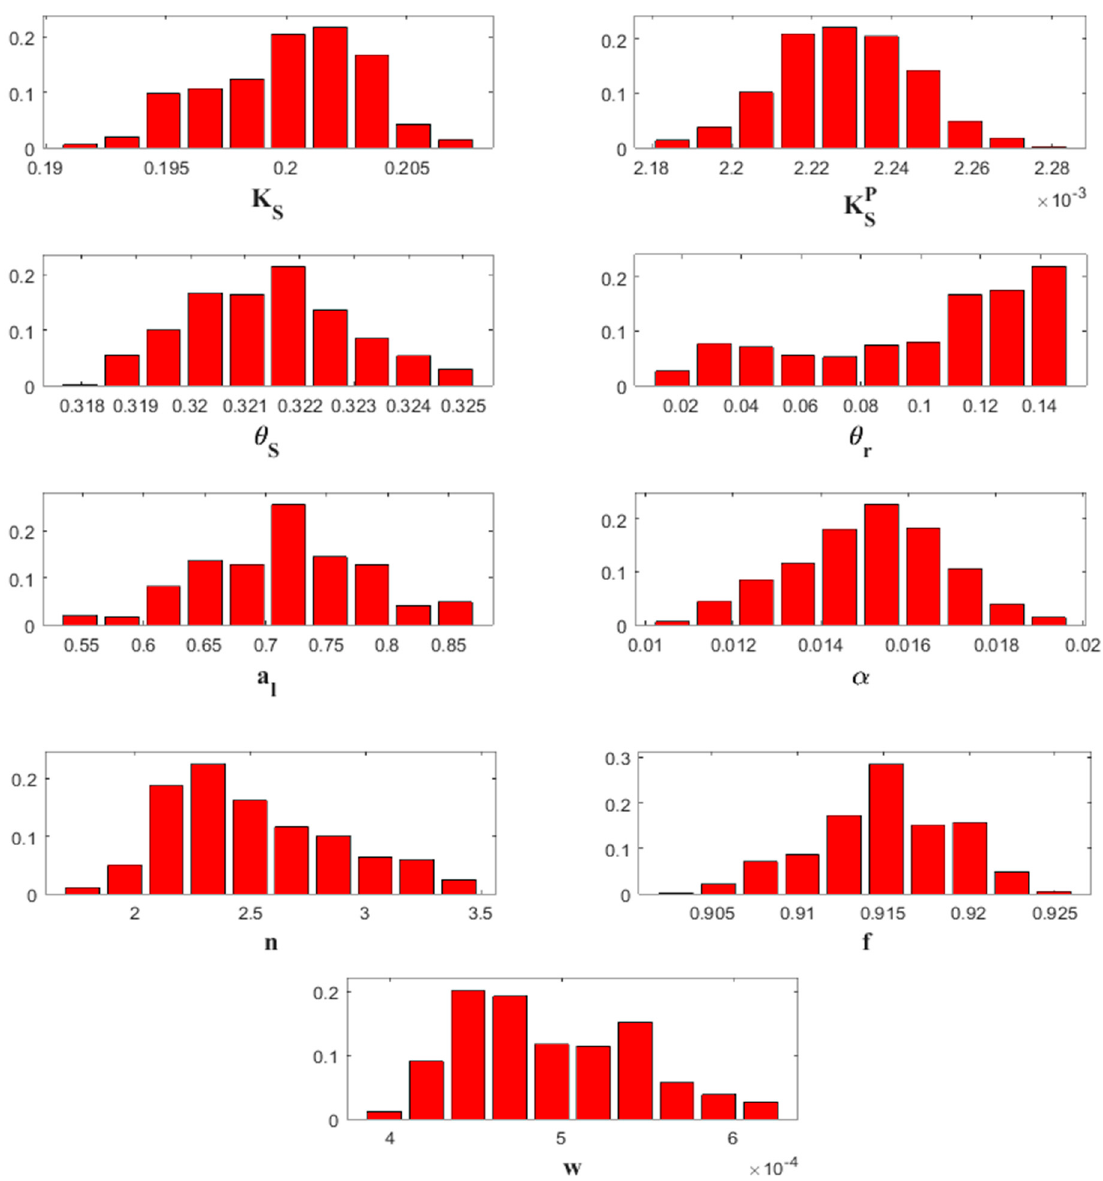
Figure 7. Histograms of marginal distribution of parameters with the mobile–immobile transport model.